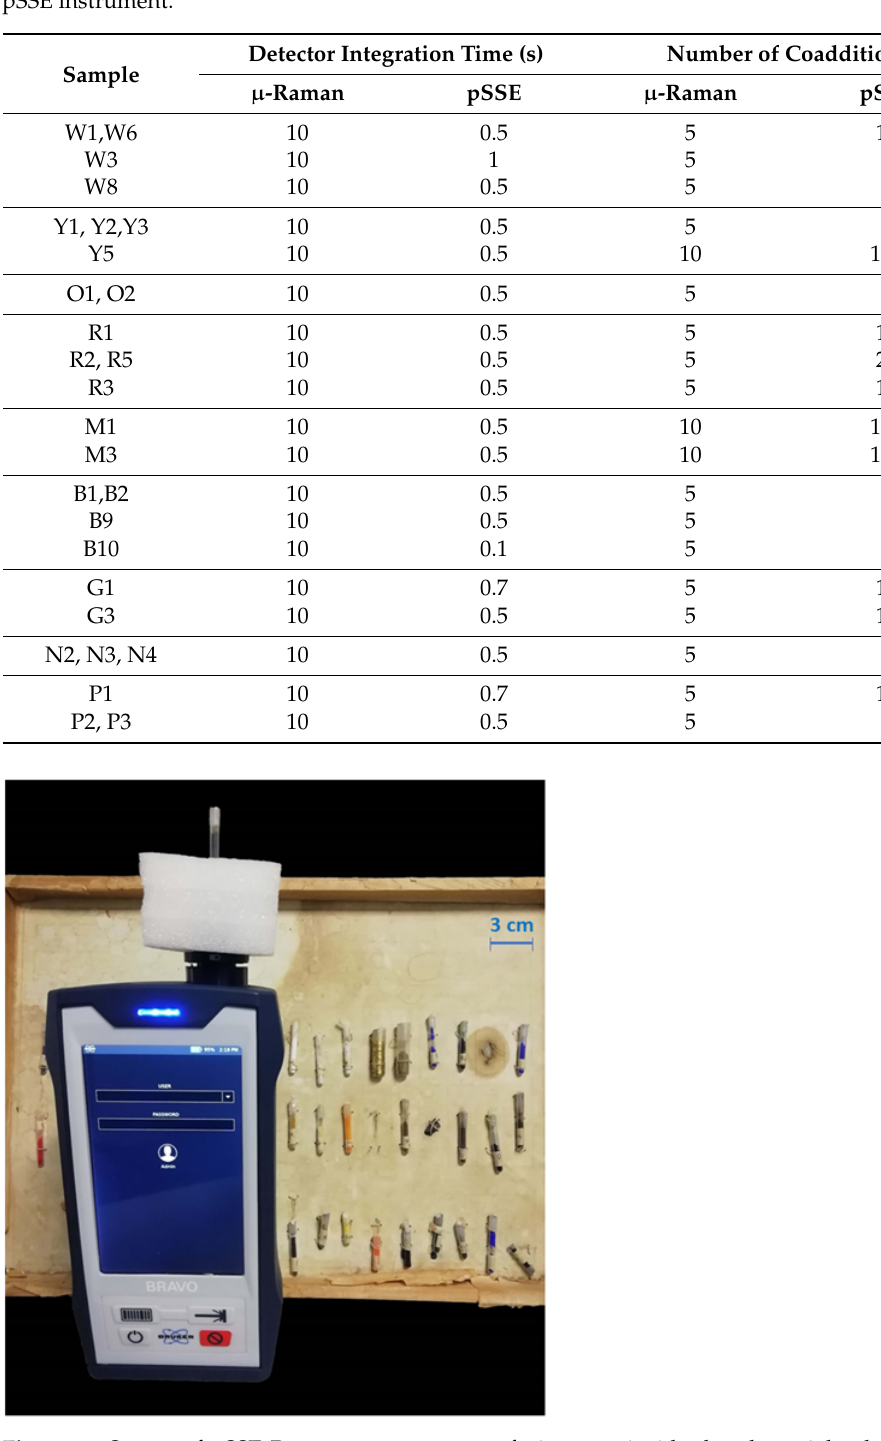
Figure 2. Set ‐ up of pSSE Raman measurement of pigments inside the glass vials placed in the laser Figure 2. Set-up of pSSE Raman measurement of pigments inside the glass vials placed in the beam. laser